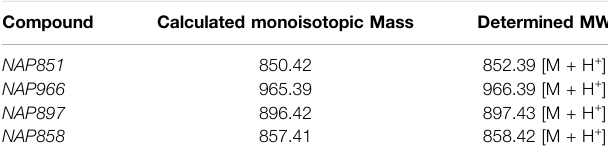
TABLE 1 | Electrospray Ionisation Mass Spectrometry analysis of synthesised